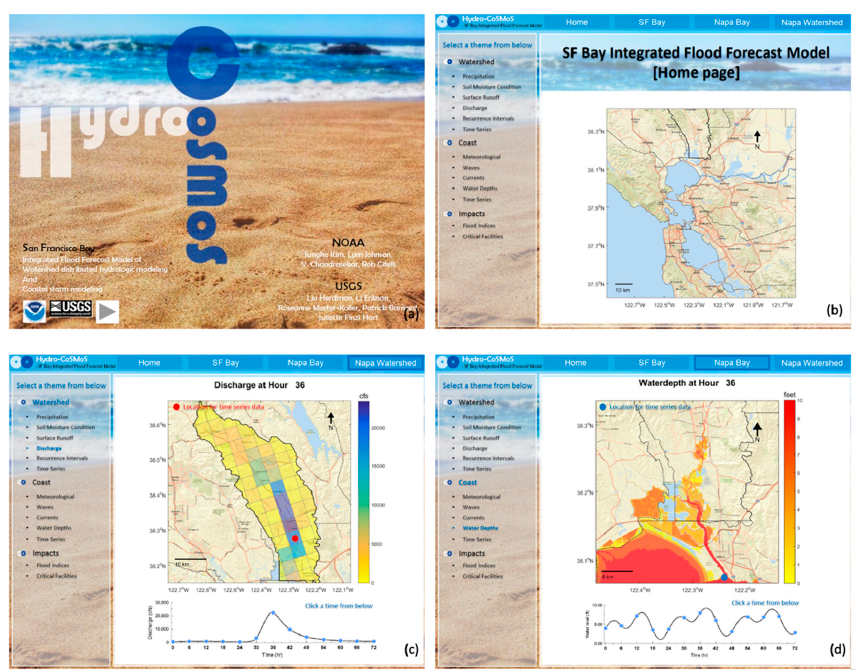
Figure 11. Example products available in the clickable PDF document used for the TTE. ( a ) document title page; ( b ) document description; ( c ) example discharge plot; and ( d ) example coastal water depth plot.